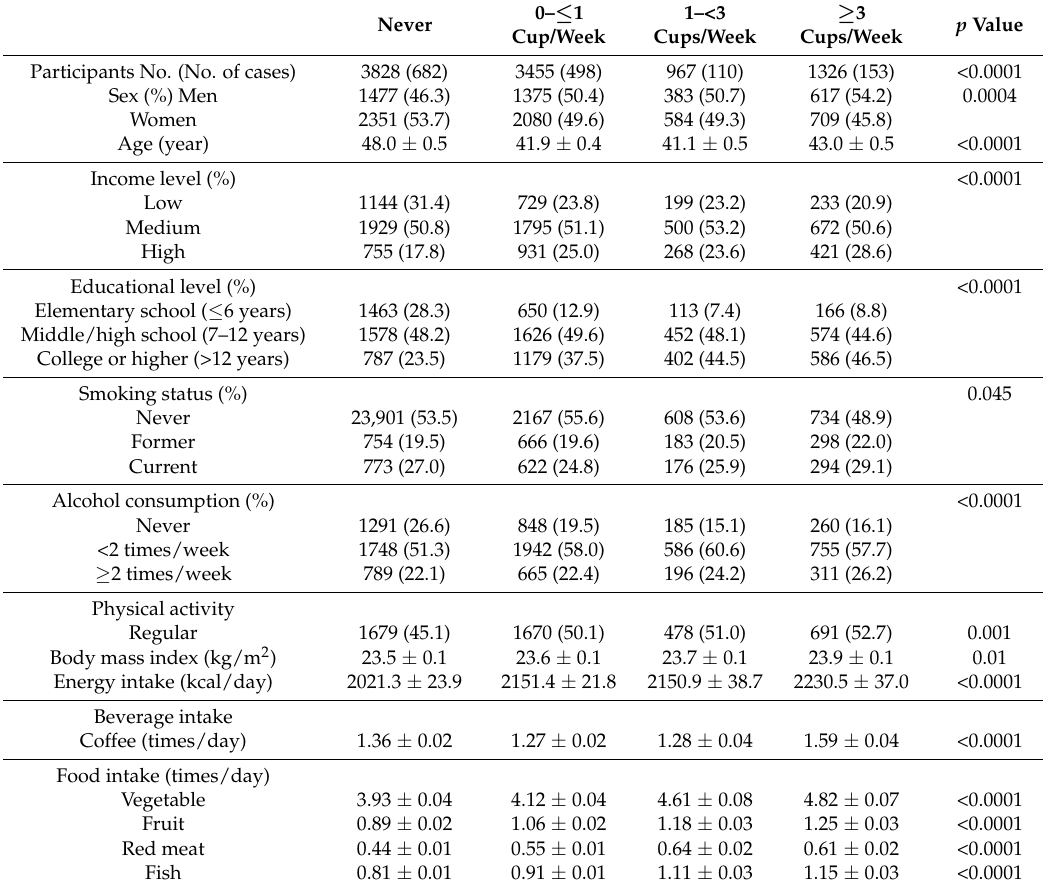
≥ 3 0– ≤ 1 1–<3 p Value Never Cup/Week Cups/Week Cups/Week